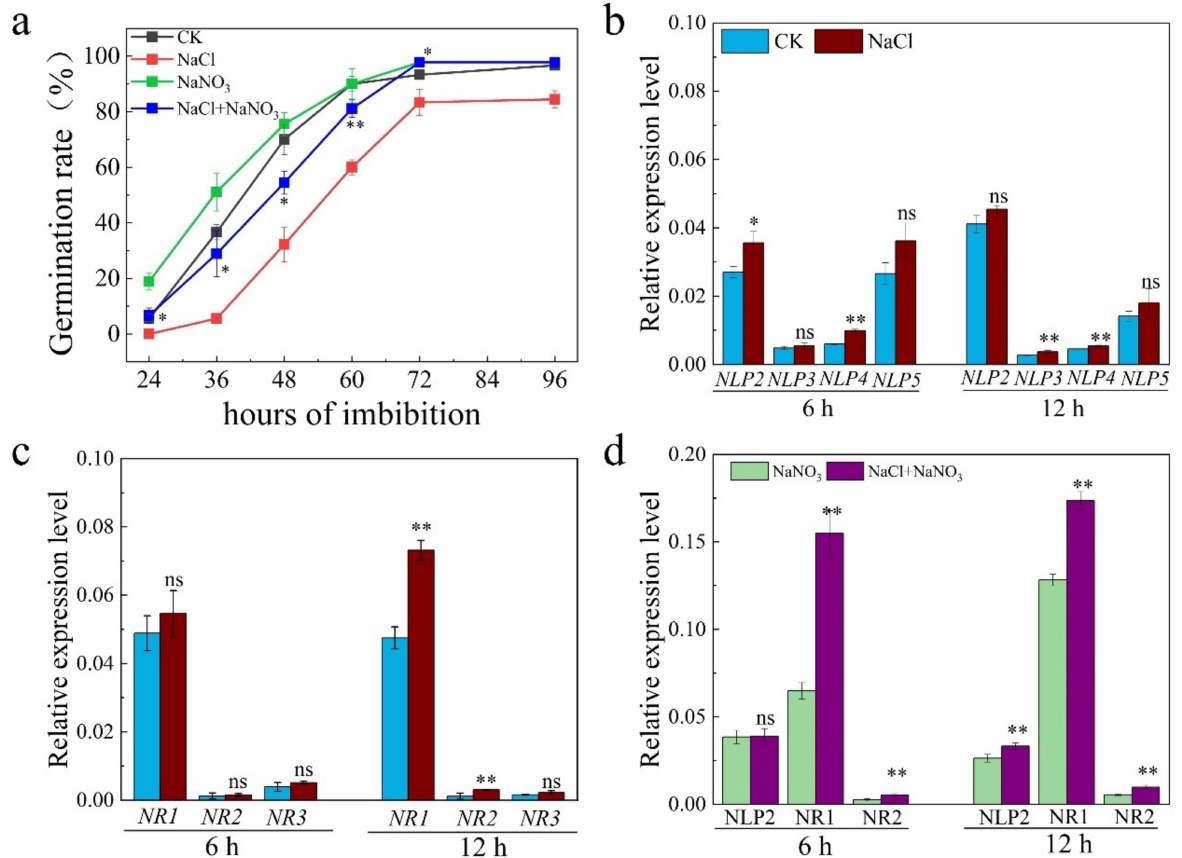
Figure 5. OsNLP2 was induced by salt stress to promote expression of OsNR gene families. ( a ) Seed germination of WT plant under water, 100 mM NaCl, 1 mM NaNO 3 and NaCl plus NaNO 3 ; ( b , c ) Expression of OsNLP and OsNR gene families in WT seed germinated under water and 100 mM NaCl treatments; ( d ) Expression of OsNLP2 , OsNR1 and OsNR2 in WT seed germinated under NaCl and NaCl plus NaNO 3 treatments. The data are the means of three independent replications (n = 50) ± SD. The asterisk (* and **) indicates a significant difference at the p < 0.05 and p < 0.01 level, respectively, and ns means not significant, by Student’s t -test